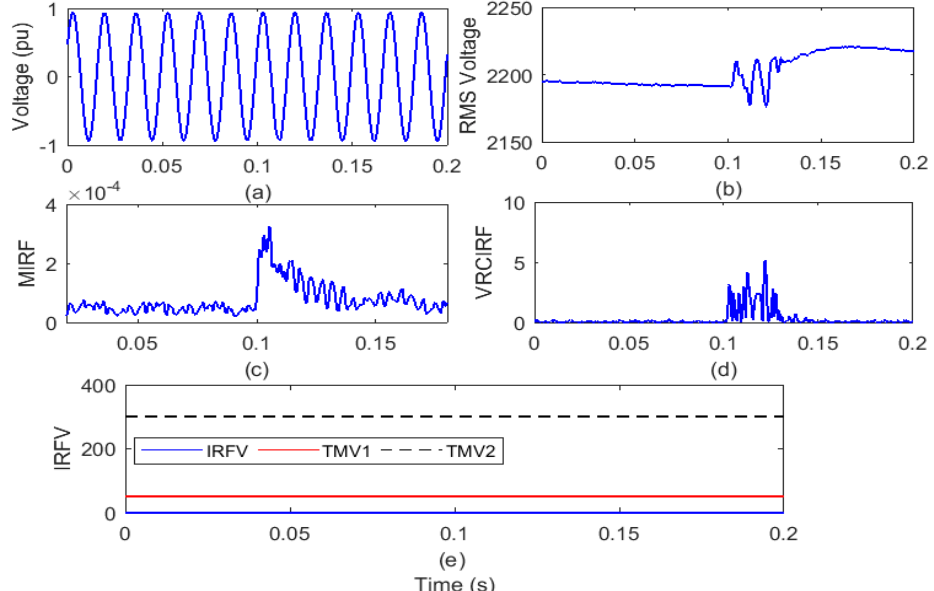
Figure 11. Outage of wind power plant from test grid ( a ) voltage signal ( b ) root means square value of voltage ( c ) median-based IRF ( d ) rate of change in voltage-based IRF ( e ) islanding recognition factor based on voltage.